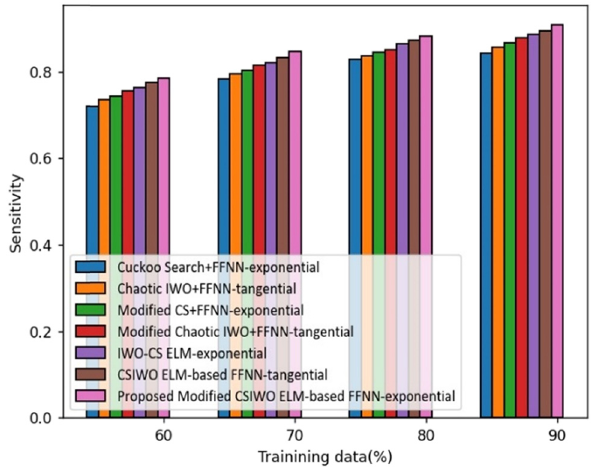
Figure 4: Analysis based on the linear value function - based sensitivity.